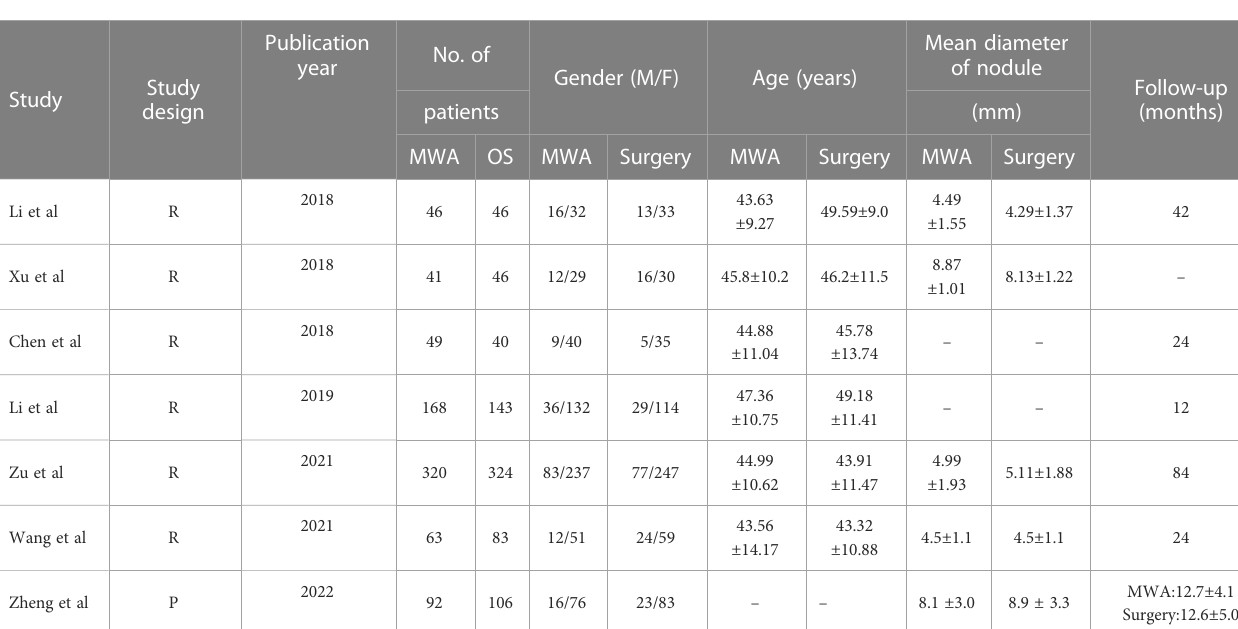
TABLE 1 Main characteristics of the included studies in the